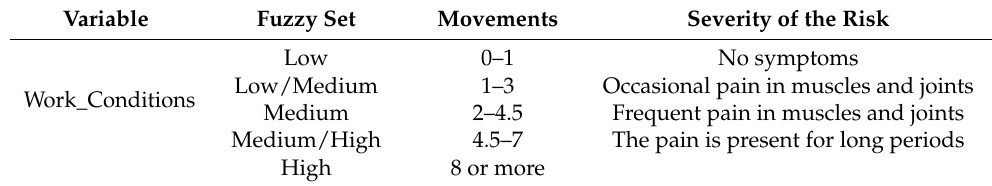
Table 8. Ranges of Work_Conditions and their fuzzy sets.